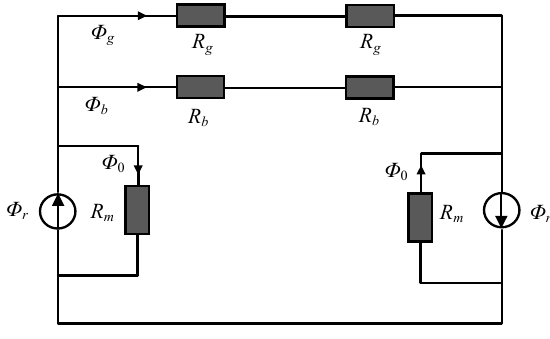
Figure 3. Flux line distribution in no-load condition.